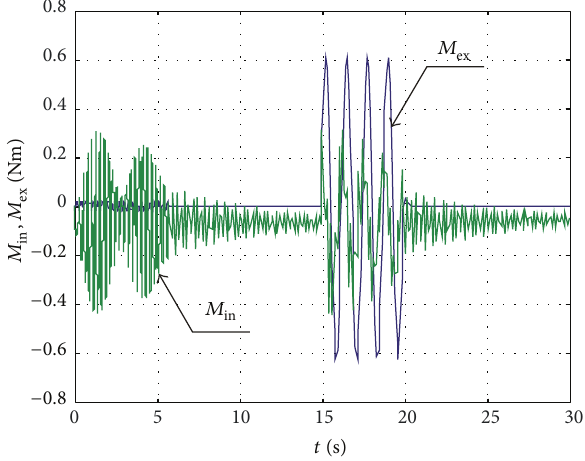
Figure 16: Time-dependent control moments 𝑀 optimum parameters of the regulator without the influence of